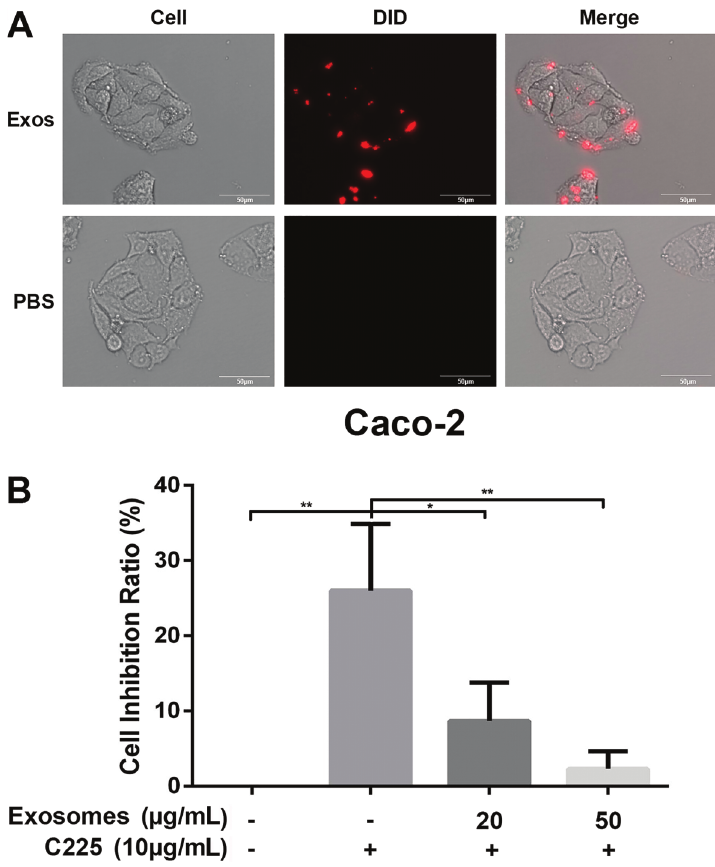
Figure 2. RKO cell-derived exosomes induced cetuximab resistance in Caco-2 cells. A , RKO- derived exosomes were labeled by DiD for 30 min followed by centrifugation at 100,000 g for 2 h (4 o C) and co-culture with recipient Caco-2 cells for 12 h (PBS as control). Then, fl uores- cence microscopy imaging con fi rmed that exo- somes were internalized by Caco-2 cells. Original magni fi cation: 200 (cid:1) . B , The MTTassay was used to evaluate the effects of RKO-derived exosomes (20 and 50 m g/mL) on Caco-2 cell viability. Exosome-induced cetuximab (10 m g/mL) resistance was observed in Caco-2 cells. Data are reported as means ± SD. *P o 0.05, **P o 0.01 (one-way ANOVA, with Tukey ’ s post hoc